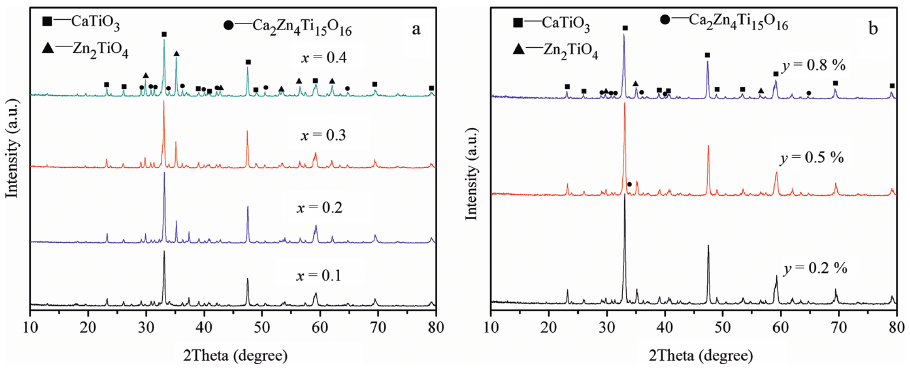
Figure 1: XRD patterns of Zn x Ca 1 – x TiO 3 :0.1%Pr 3 + (a) and Zn 0.2 Ca 0.8 TiO 3 : y Pr 3 + (b).